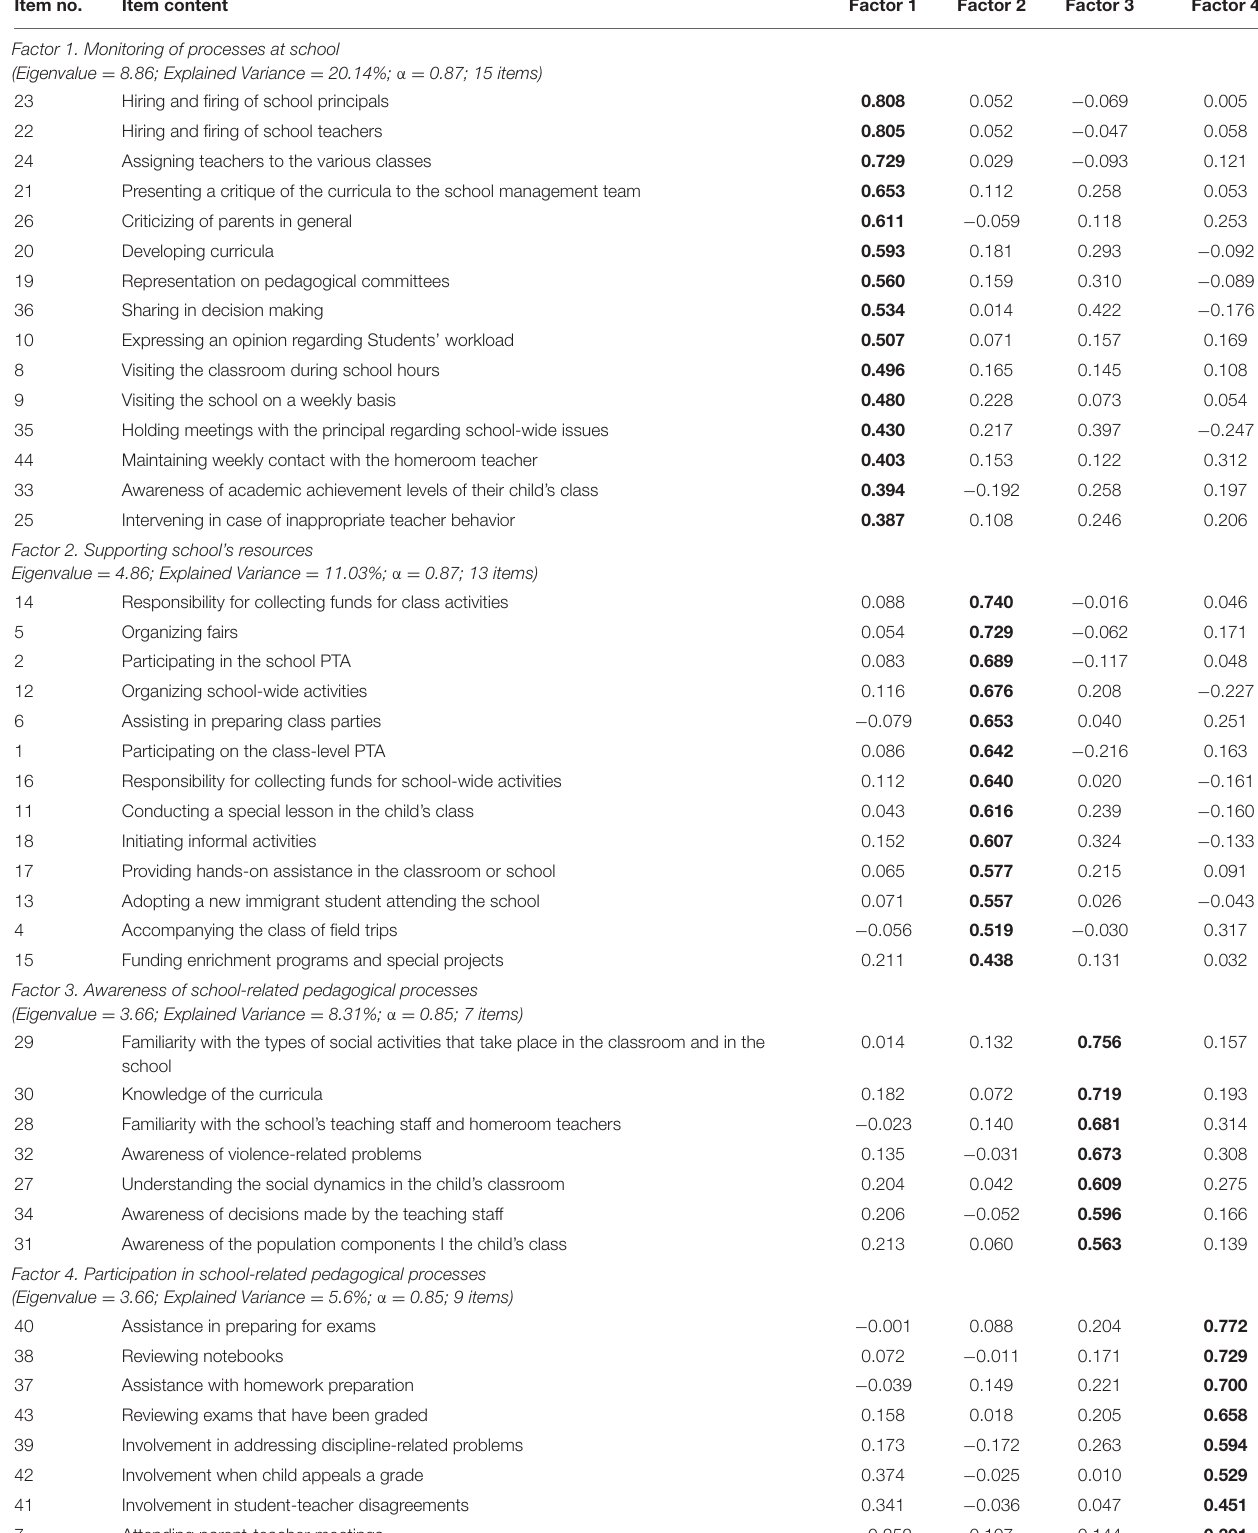
TABLE 2 | The scale of parents’ perception of “parental involvement.” Item